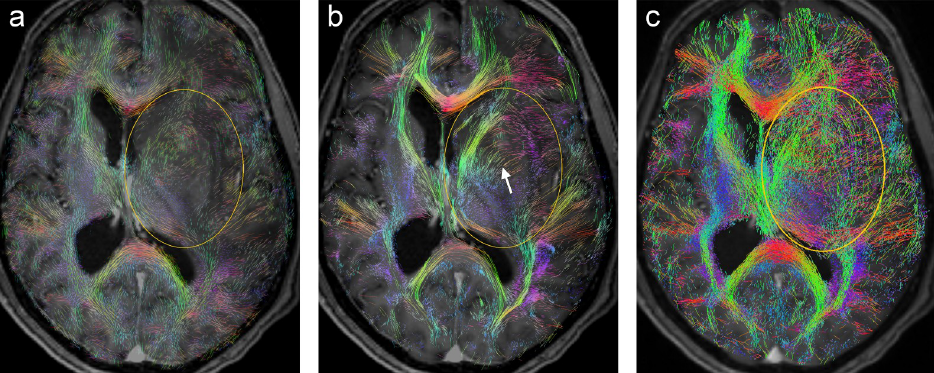
Fig 9. Visualization results from patient E: (a) Transaxial A-Glyph LIC slice with ROI (yellow), and corresponding slices from deterministic (b) and probabilistic (c) tractography results.